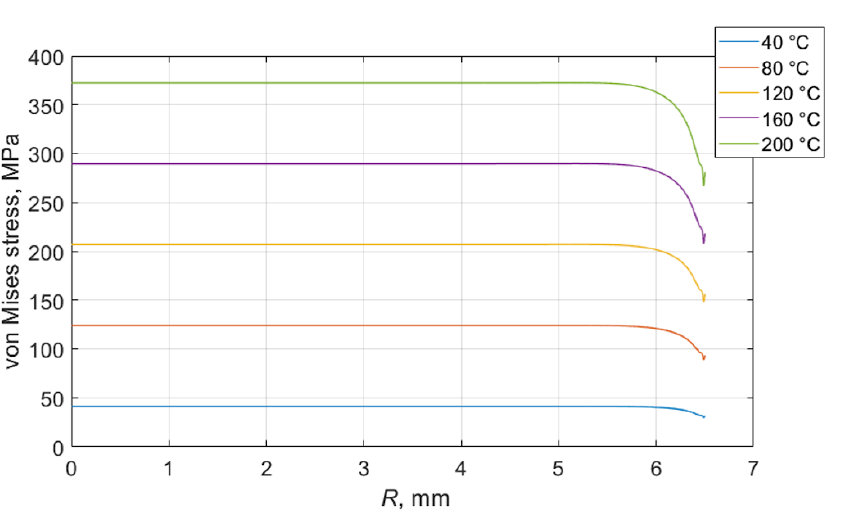
Figure 5. Distribution of von Mises stress in silver coating along the radius of piezoelectric disc.